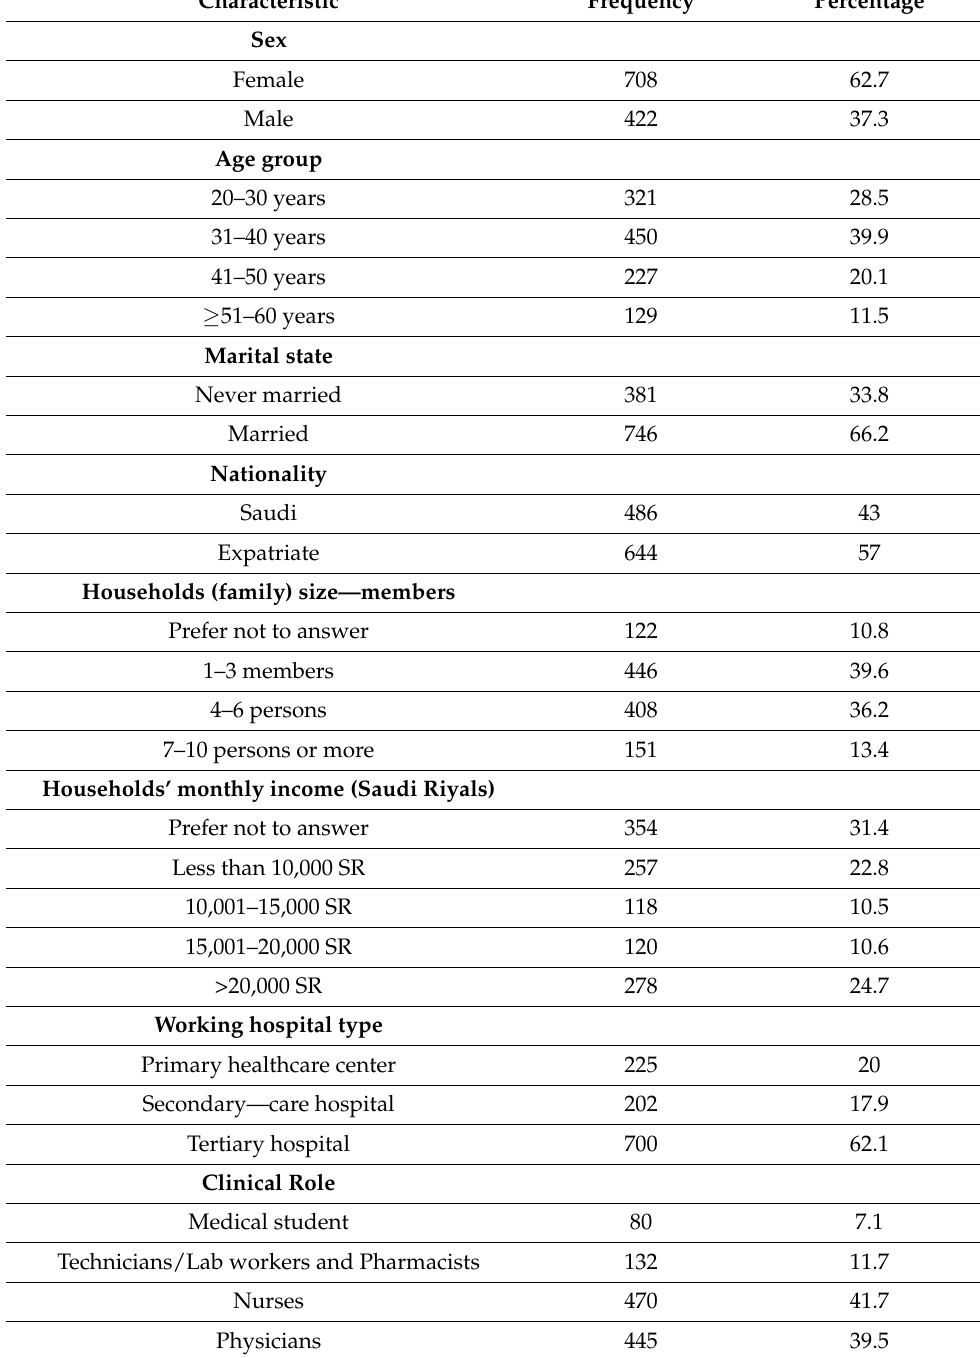
Table 1. Participants’ baseline sociodemographic and professional characteristics. N =